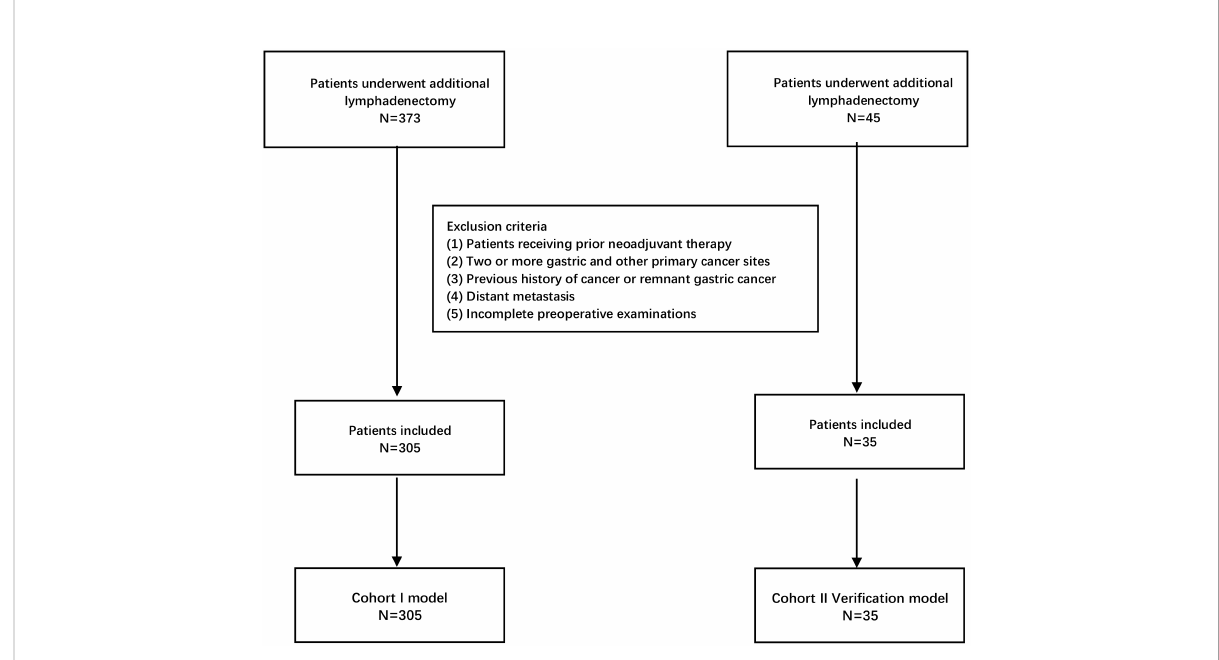
FIGURE 1 Flowchart of patients included in the study for construction models and external validation models according to the inclusion and exclusion